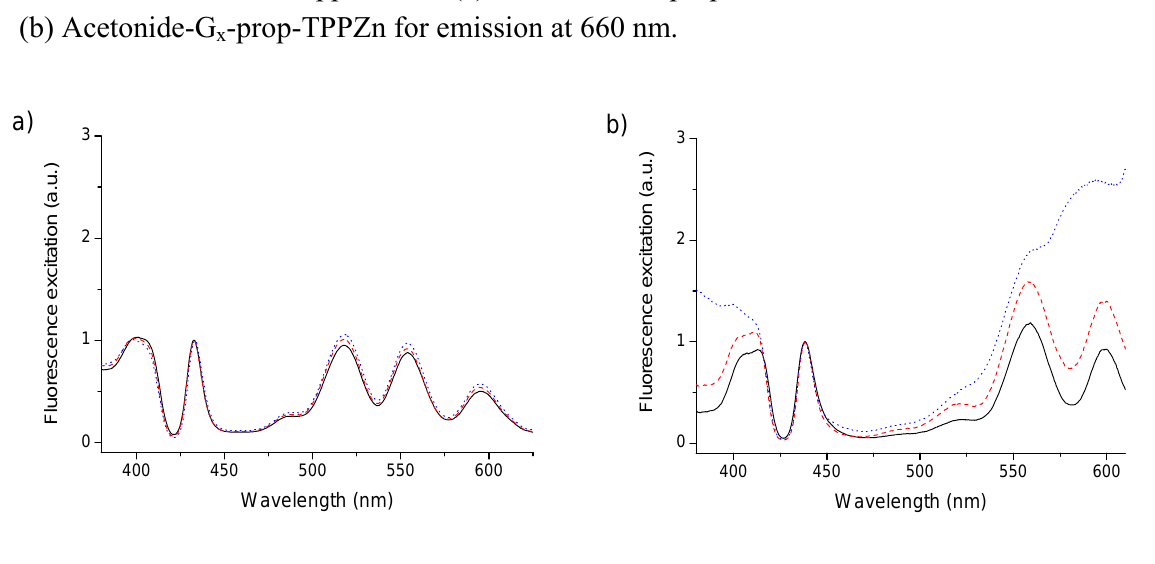
-prop-TPPH for emission at 650 nm. x 2